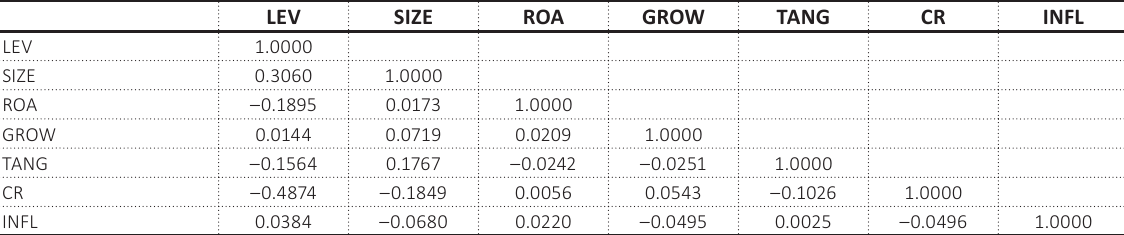
Table 2. Correlation matrix of independent variables